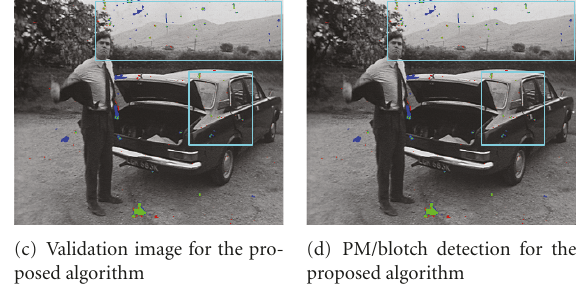
Figure 16: This figure illustrates the superior blotch detection rate of the proposed algorithm over the Bornard algorithm in the “jacket” sequence. The highlighted regions of the frame indicate blotches missed by the Bornard algorithm (image (a)) that are detected by the proposed algorithm (c). The blotches missed by the Bornard algorithm are detected as PM (b). The value of δ t used to generate the images in this figure is